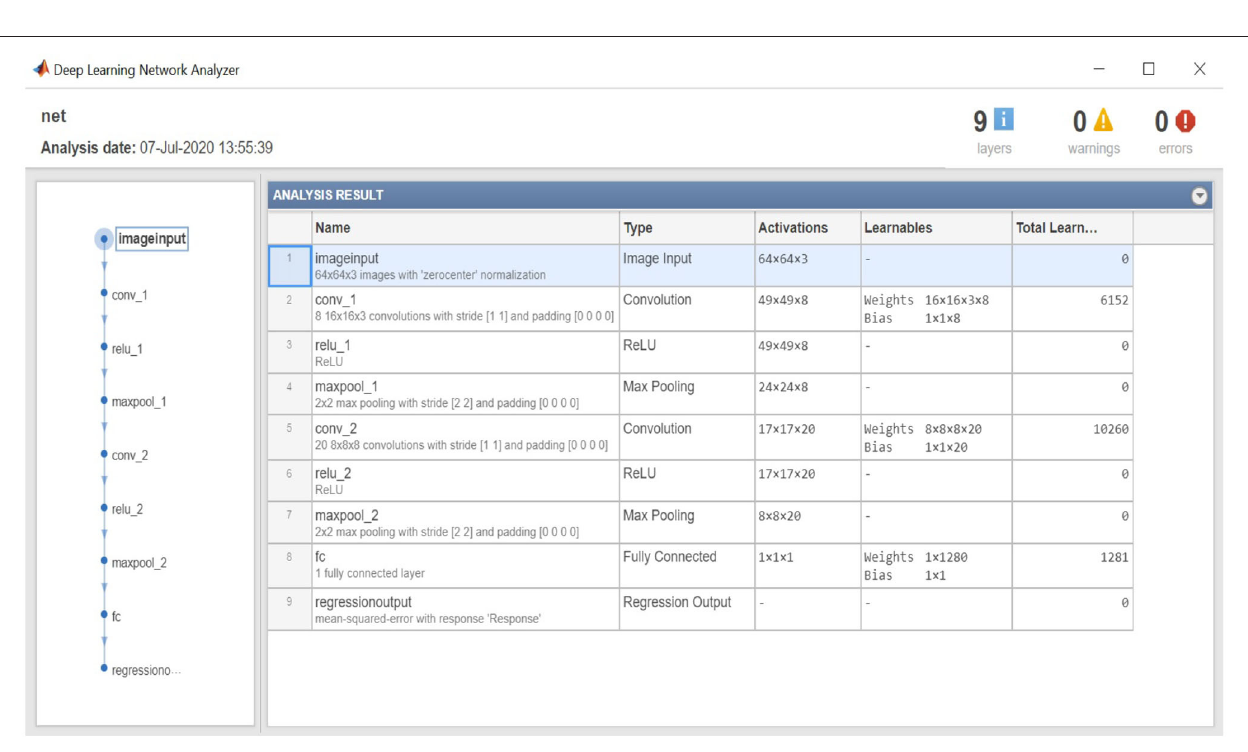
FIGURE 8 | The 9 layer architecture of the convolutional neural network (CNN) constructed for Experiment 1 (CNN 1 ) with the number of activations per layer and total number of learnable weights and bias in the convolutional layers and fully connected